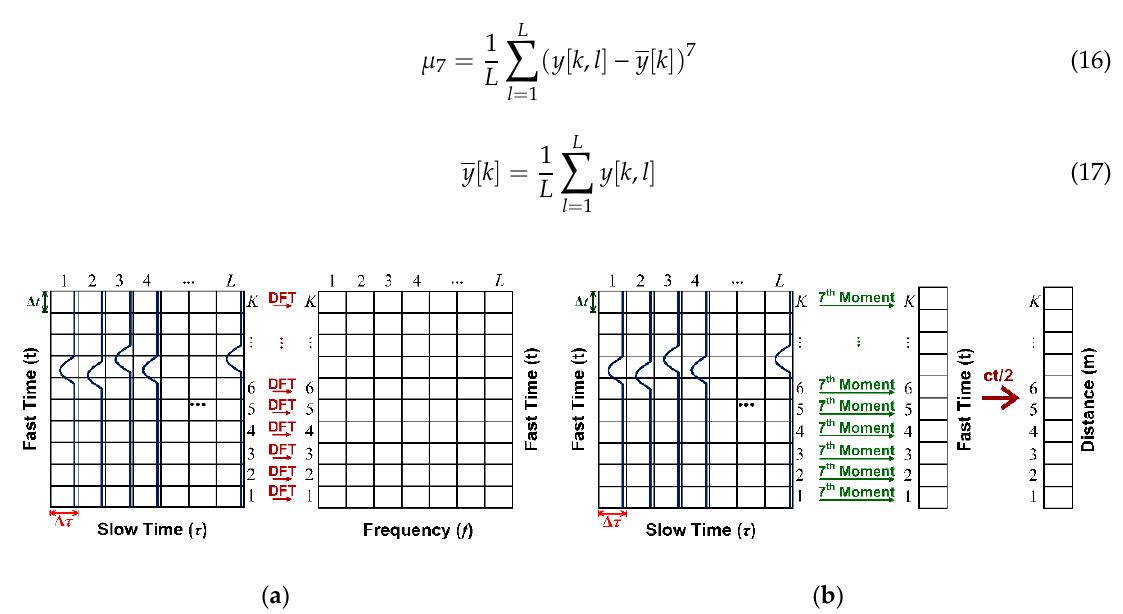
Figure 9. Respiration rate and range estimation: ( a ) DFT doppler frequency; ( b ) statistical 7th moment.